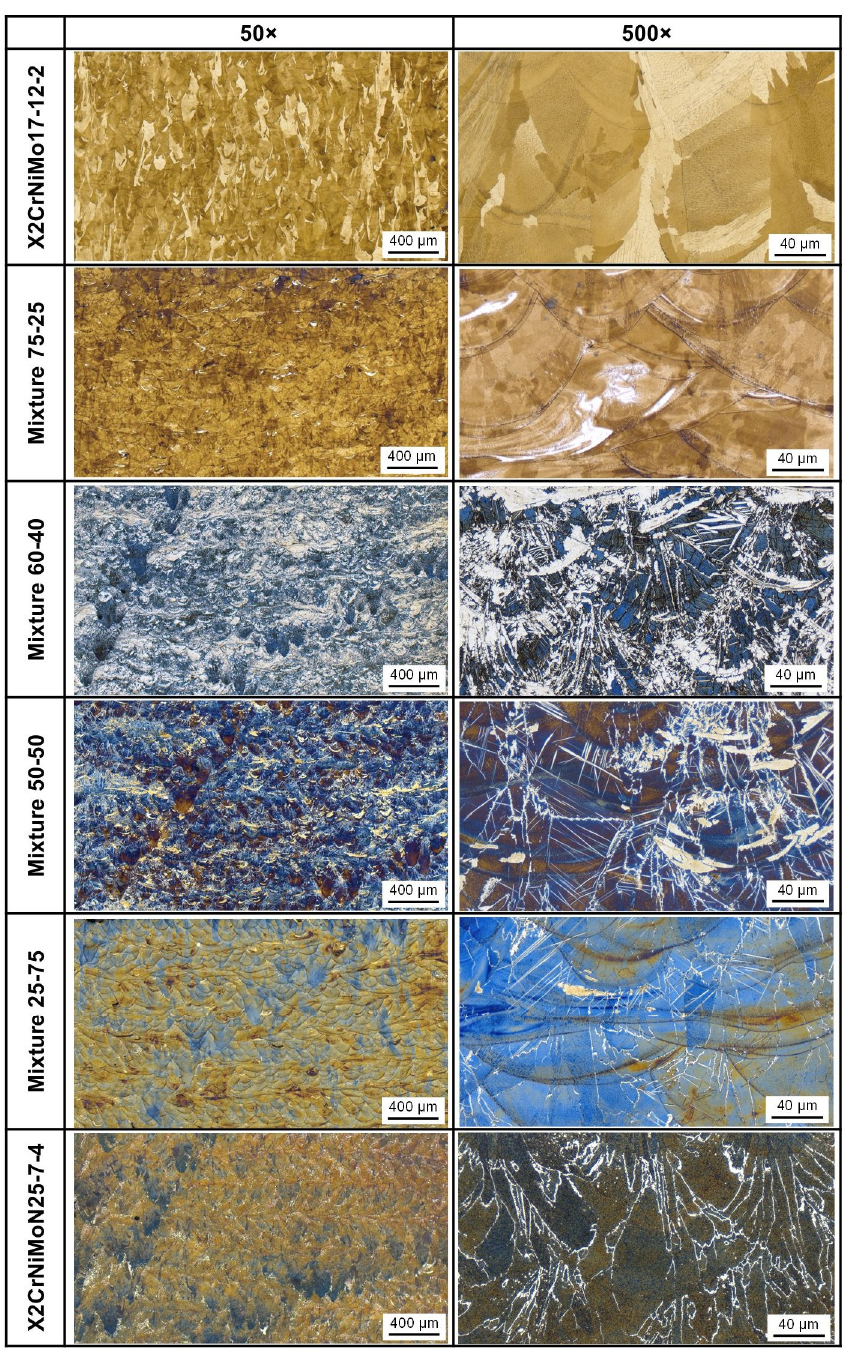
Figure 10. Light optical microscopy of the as-built parts from the initial powders and the various powder mixtures. The parts were built under the standard process condition (Laser power 250 W, laser scan speed 800 mm/s). The etchant Beraha I was used for all the samples except the sample Mixture 75-25, which was etched with Lichtenegger and Bloech. Building direction is upward for all images.